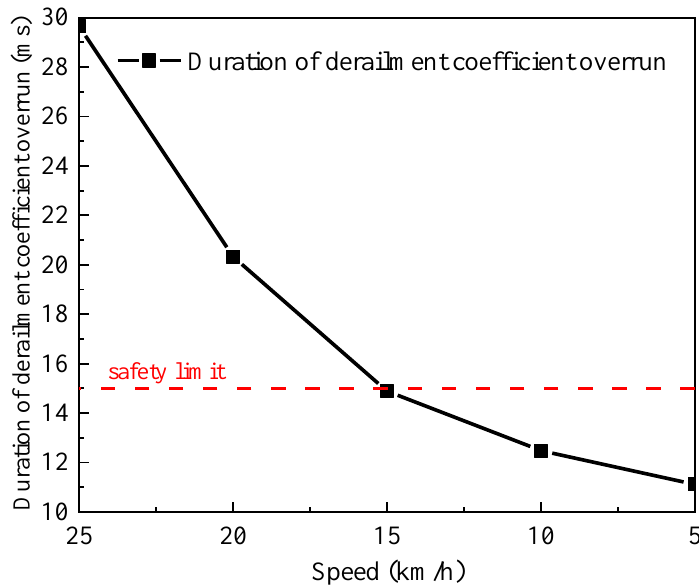
Figure 20. Duration of derailment coefficient overrun vs. train running speed.